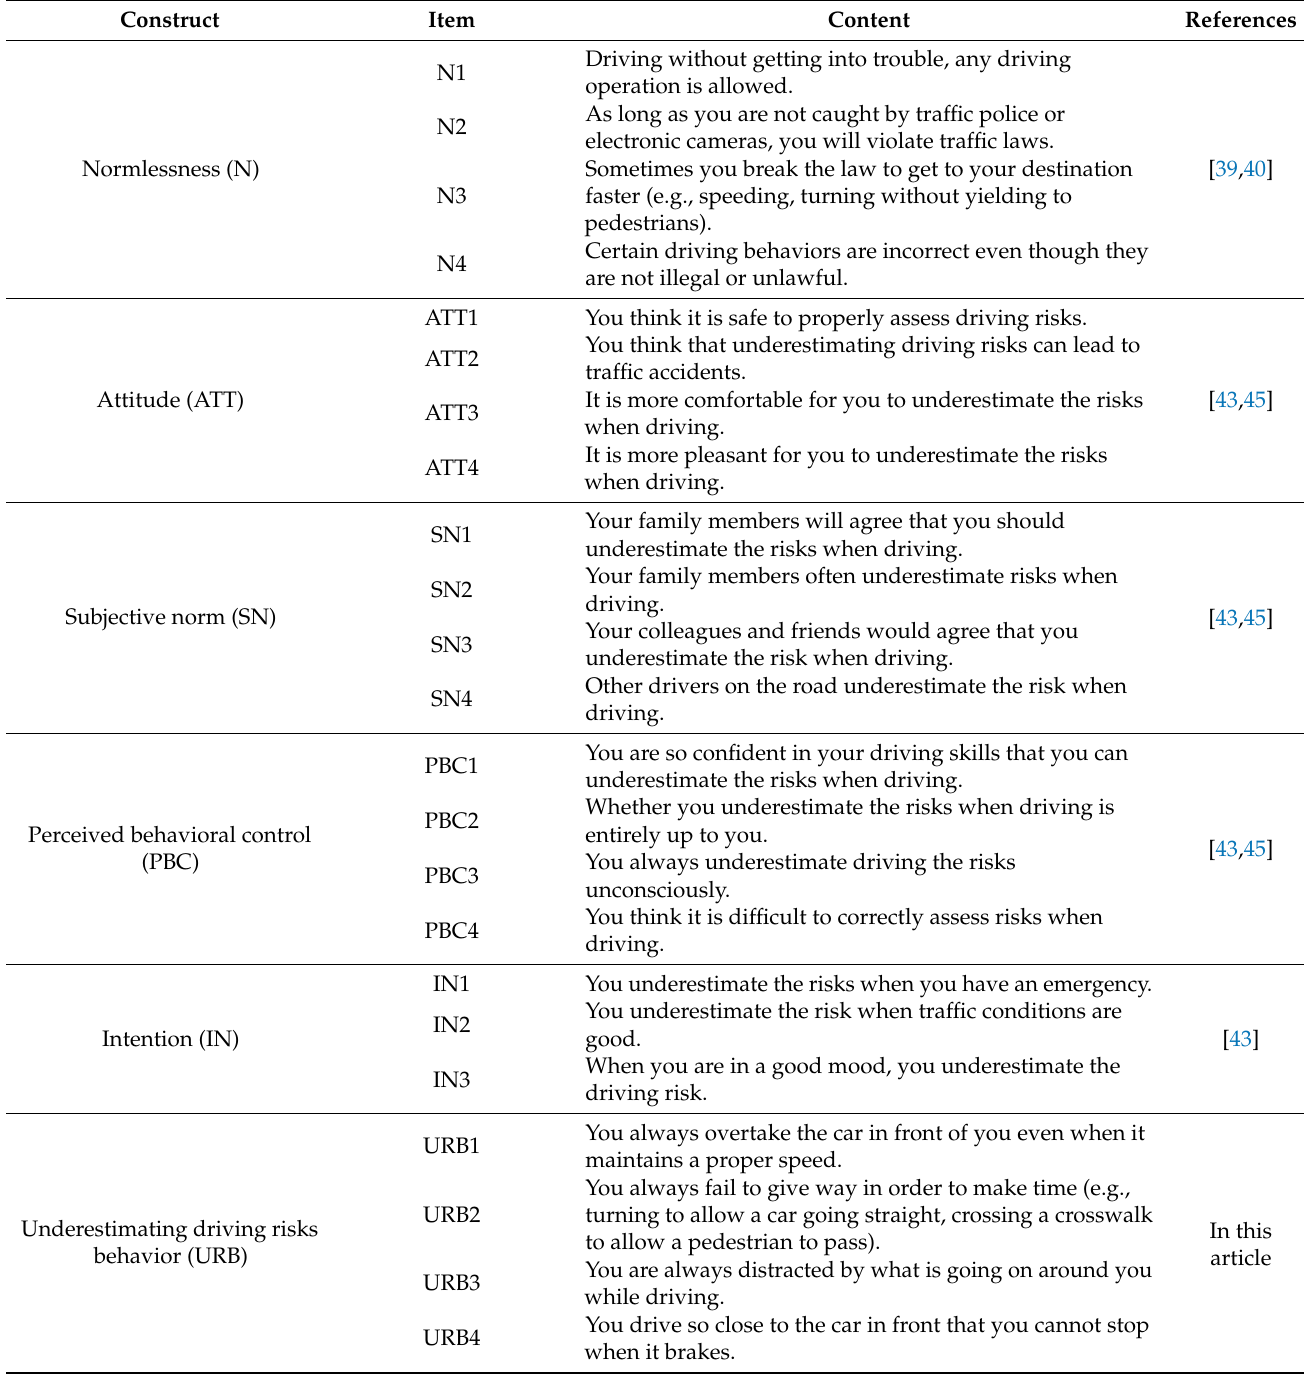
Table 1. Scale content and corresponding